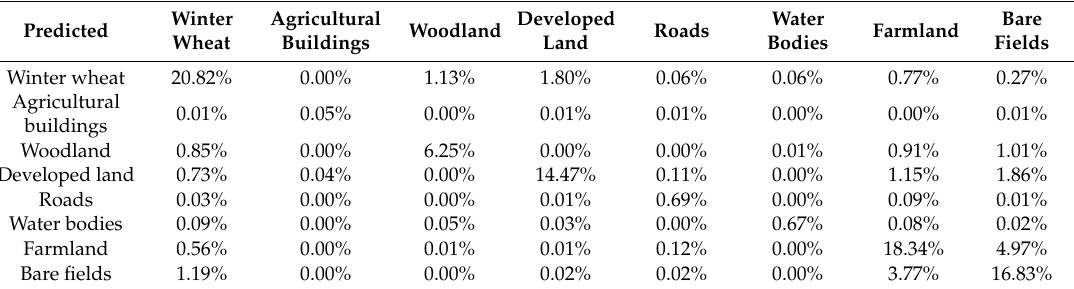
Table 5. Confusion matrix for the Segnet models.